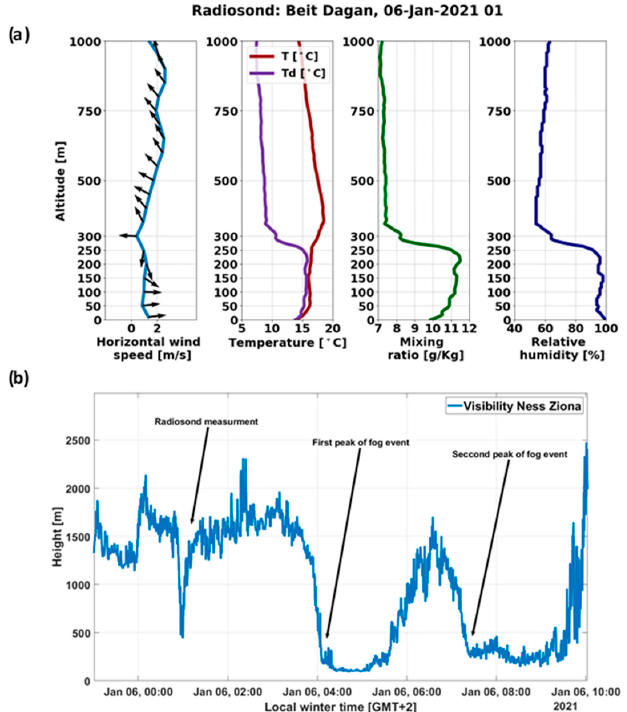
Figure 2. ( a ) IMS Radiosonde measurement before and during fog periods, from left to right: Horizontal wind speed and direction, air and dew point temperatures, mixing ratio and relative humidity. ( b ) Visibility values in Ness Ziona before and during the fog event.